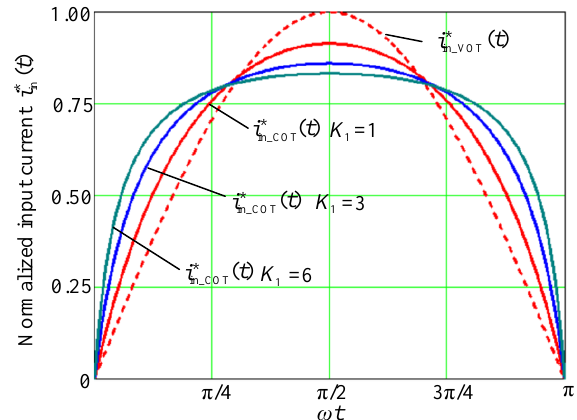
Figure 5. Comparison of the normalized input current waveform .